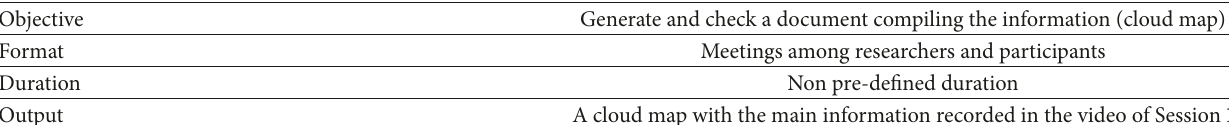
Table 3: Summary of the characteristics of Session 2.